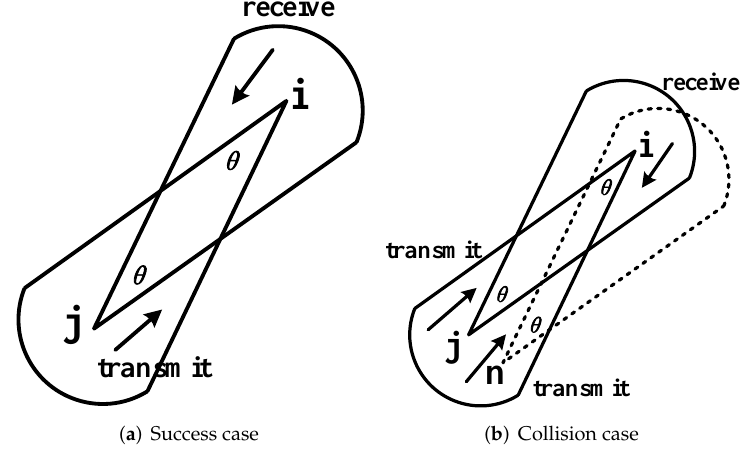
Figure 4. Link established